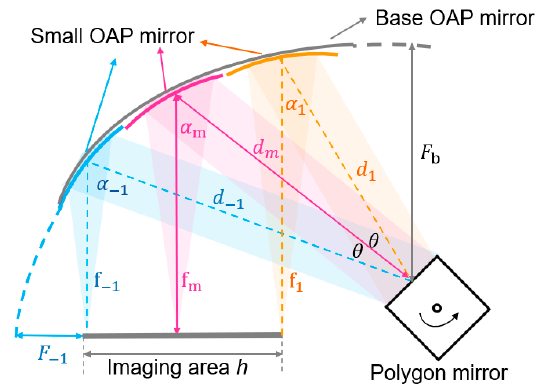
Figure 7. Schematic of the integrated OAP mirror, which includes three small OAP mirrors; the dashed line indicates the base OAP mirror, which guides the parameter design of each small OAP mirror.